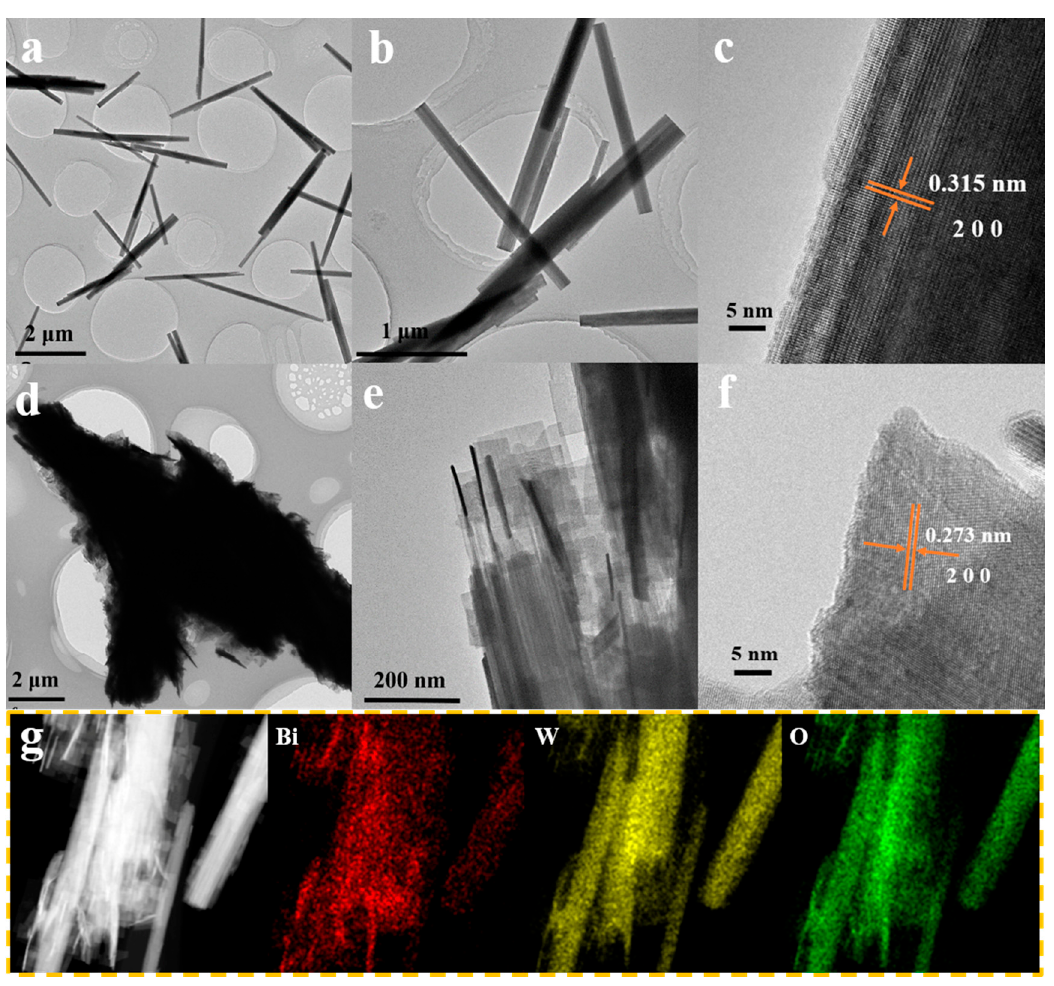
Figure 5. The transmission electron microscope (TEM) and high-resolution-TEM (HRTEM) image of WO 3 ( a – c ) and BW3 ( d – f ) and the STEM mapping ( g ) of BW3.